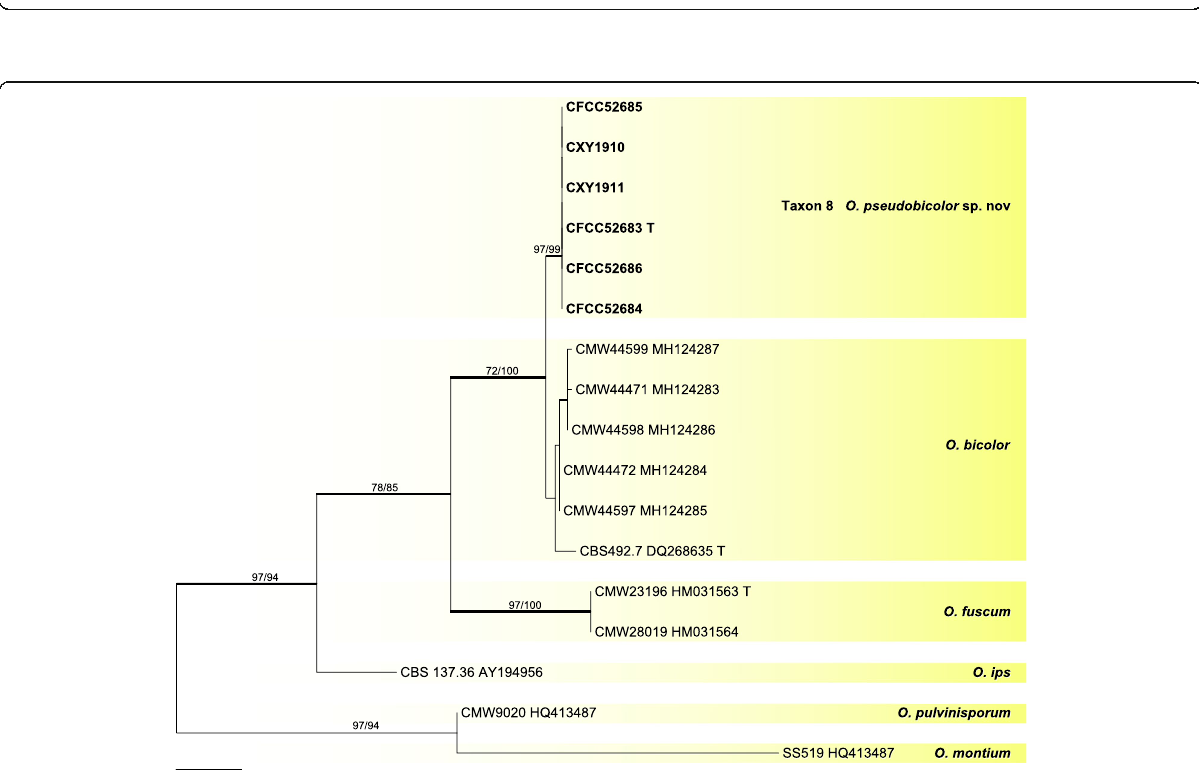
Fig. 8 ML tree of O. ips complex generated from the β T sequence data. Sequences generated from this study are printed in bold. Bold branches indicate posterior probability values ≥ 0.9. Bootstrap values of ML/MP ≥ 70% are recorded at nodes. T = ex-type isolates